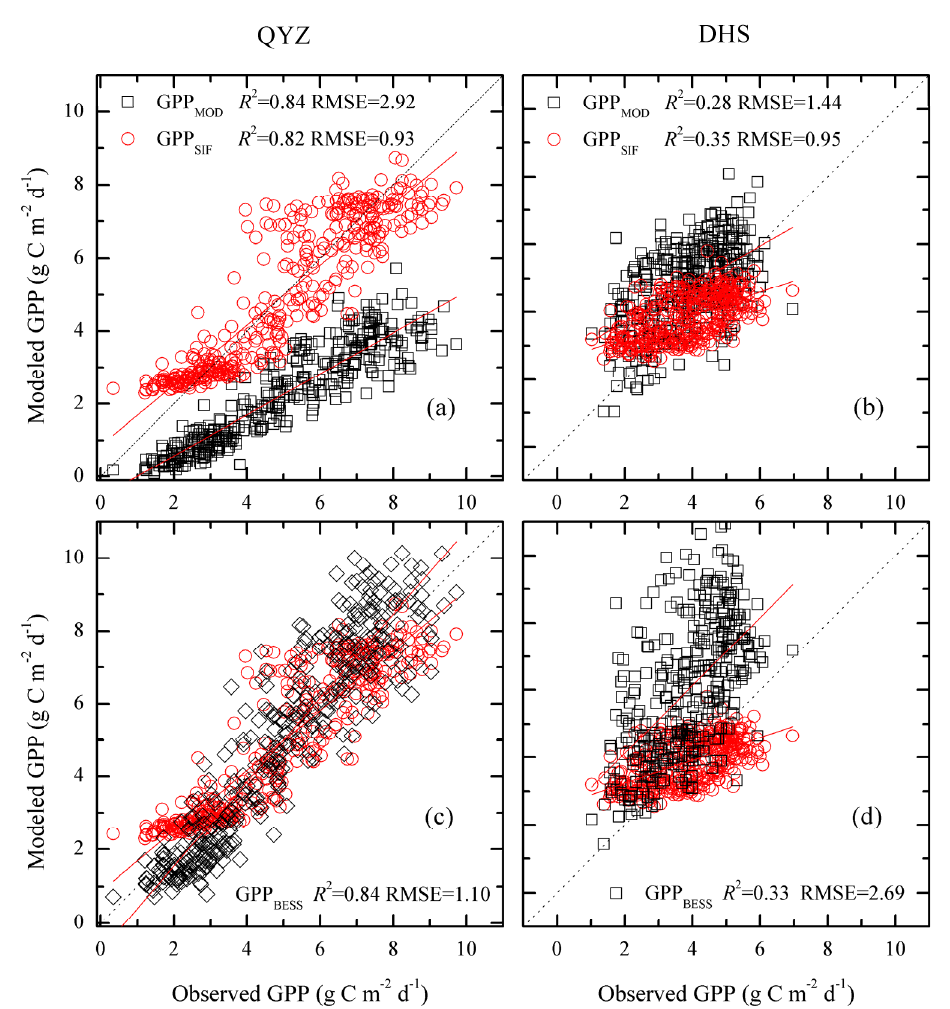
Figure 6. Leave-one-out cross-validation of the model-estimated GPP relying on time-series SIF data (GPP SIF ) and the associated MODIS GPP (GPP MOD ) and BESS GPP (GPP BESS ) products across the two subtropical forest (QYZ, evergreen needleleaf forest; DHS, Evergreen broadleaf forest) flux sites. The dotted line is a 1:1 line.